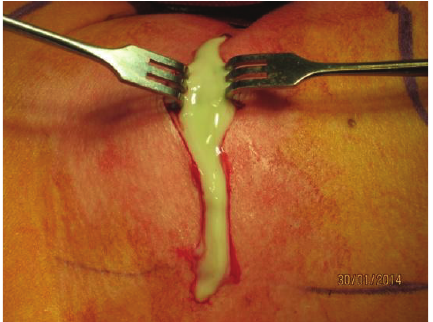
Figure 3: Preoperative view.